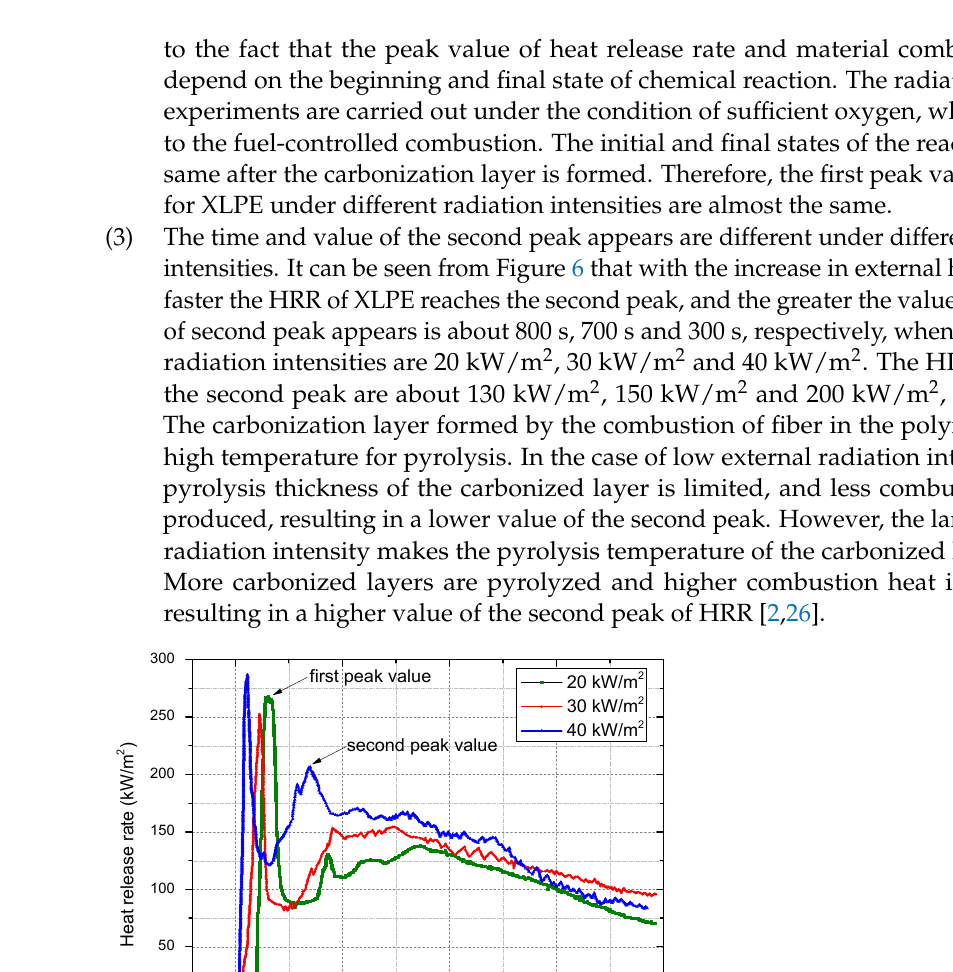
Figure 7. Schematic diagram of simplified cable model. The main assumptions of the model are as follows: (1) Only the upper surface of the cable is exposed to the external radiant heat flow, and the convective heat loss and radiant heat loss caused by the increase in surface tem- perature is considered. (2) The heat transfer inside the cable is one-dimensional transient heat conduction. (3) When the material surface reaches the critical temperature t ig , the material is ignited.